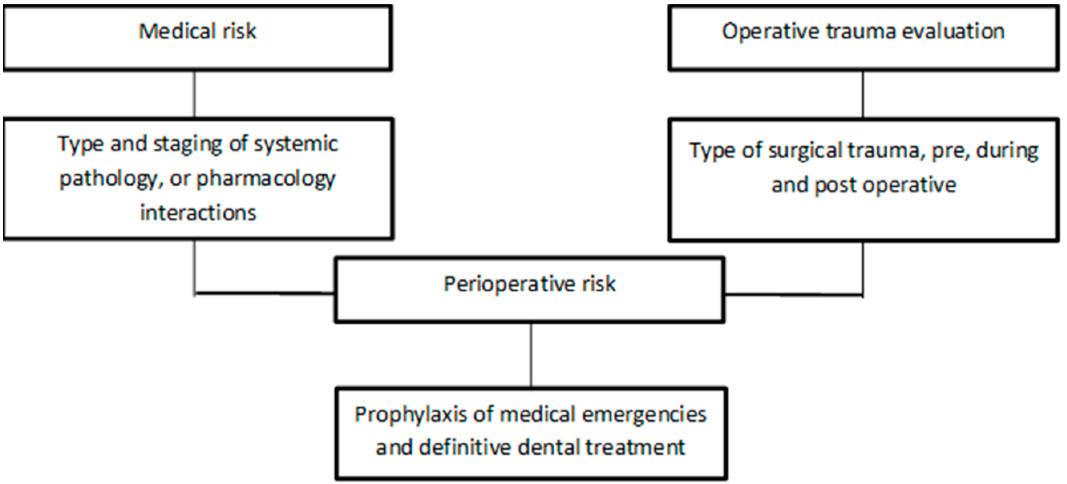
Figure 1. Cardiopatic patients risk flow chart.